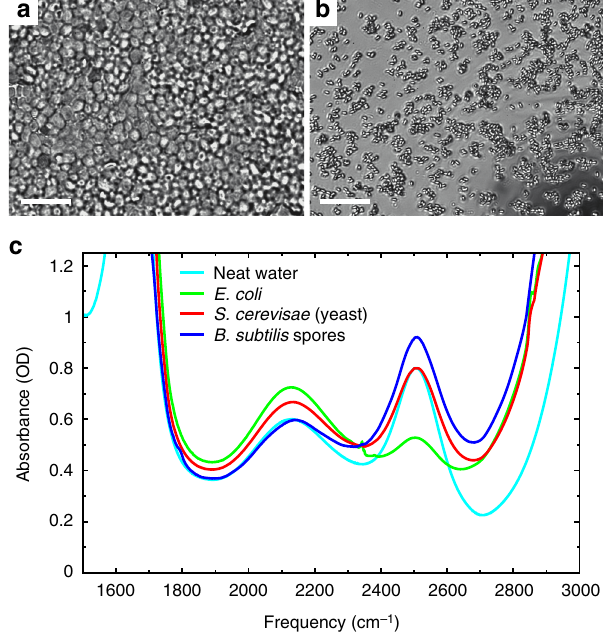
Fig. 1 Organisms investigated in this study. Microscope images of the investigated samples of a Saccharomyces cerevisiae (yeast), and b Bacillus subtilis spores. The bar represents 10 μ m. Note that in the yeast sample the extracellular space is fi lled with water, and in the spore sample mostly with air. c IR-absorption spectra of the samples. The peak at ~2500 cm − 1 , due to the OD-stretch mode of HDO, is used to probe the orientational dynamics of the intracellular